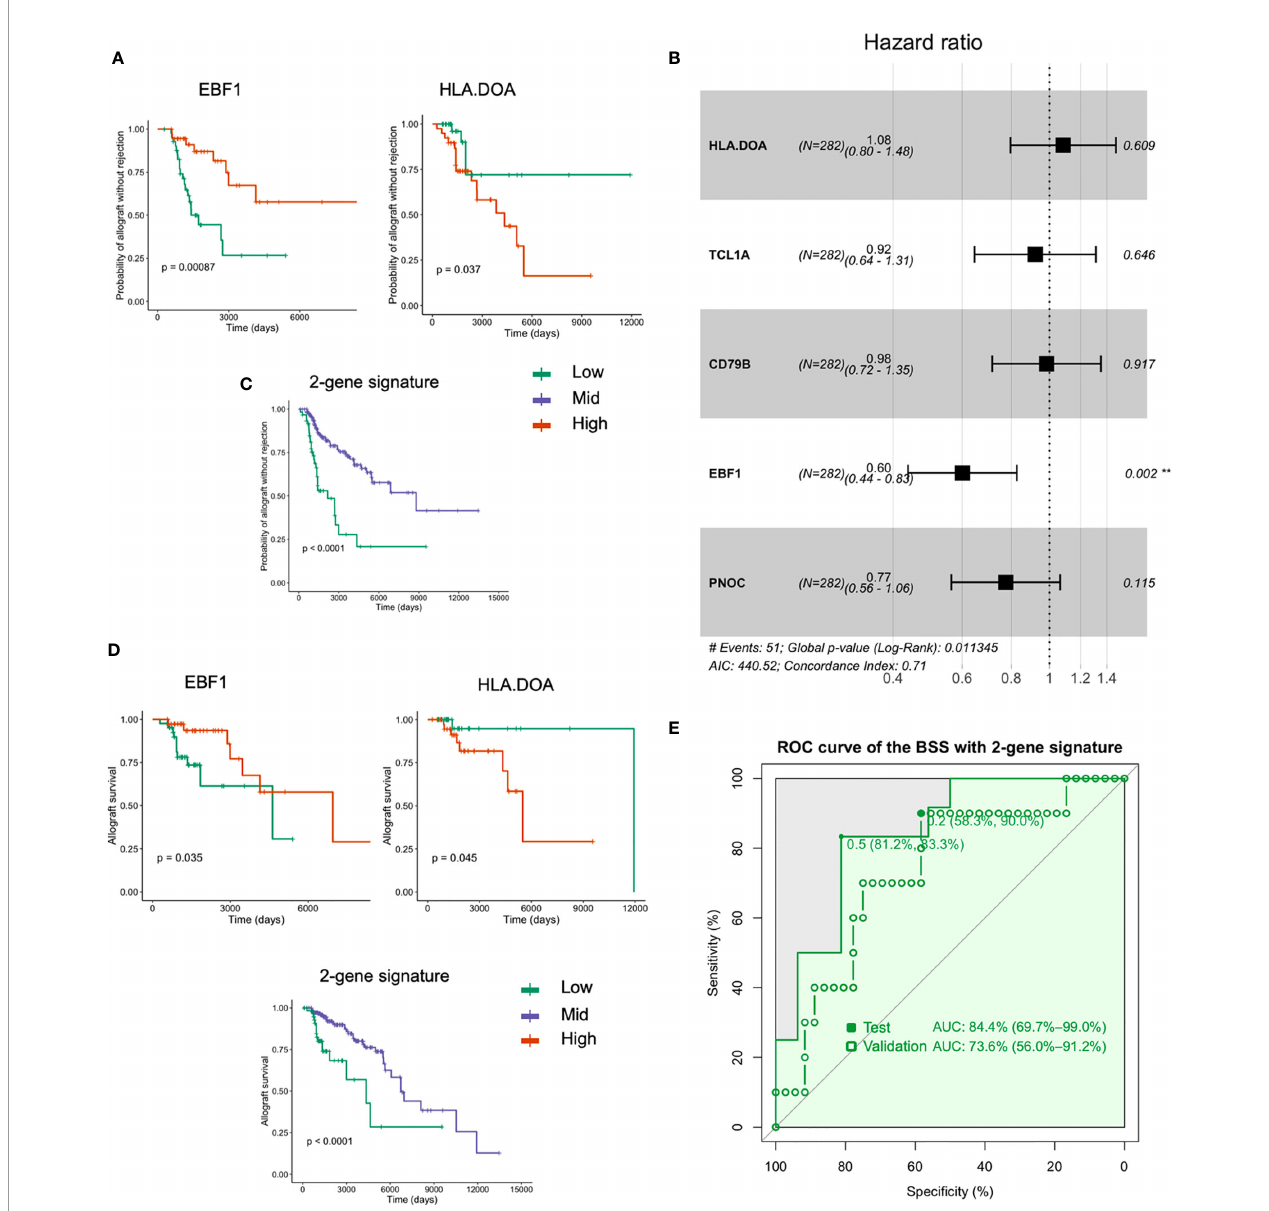
FIGURE 4 | HLA-DOA and EBF1 are associated with graft rejection and allograft survival. (A) The survival curves for HLA-DOA and EBF1 are plotted (n = 282). (B) EBF1 independently predicted renal graft rejection. (C) Patients with a low expression of the 2-gene signature had poor outcomes, while those with higher expression had a longer graft with stable function. (D) The rejection curve for HLA-DOA and EBF1 are plotted. The patients with a low expression of the 2-gene signature experienced faster graft loss. (E) An AUC of 84.4% could be achieved using EBF1 and HLA-DOA with the BSS model, while an AUC value of 73.6% could be achieved in the validation dataset 2. **P <